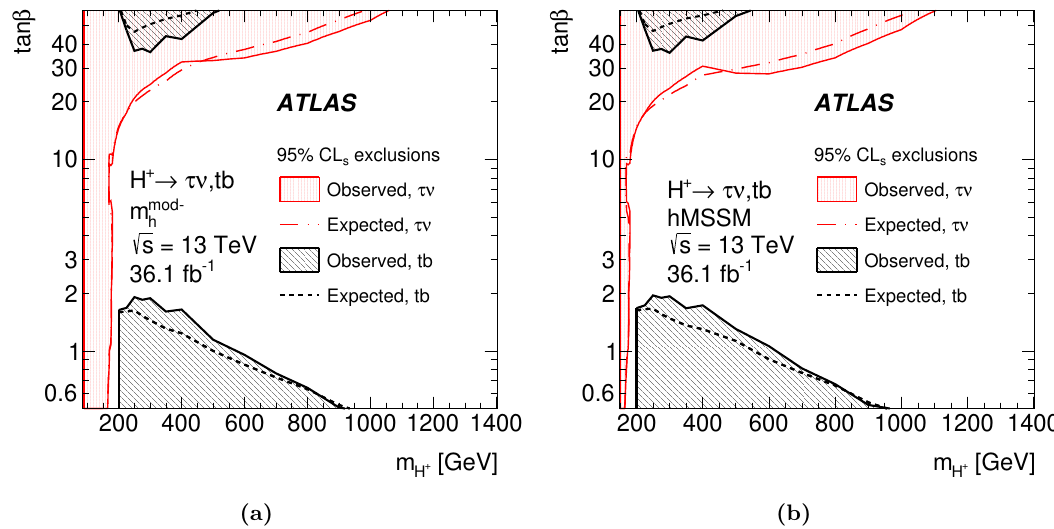
Figure 10. Expected and observed limits on tan (cid:12) as a function of m and the hMSSM [29] (right) scenarios of the MSSM. Limits are shown for tan (cid:12) values in the range of 0.5{60, where predictions are available from both scenarios. The limits are a superposition of the results obtained in the analysis presented here, and the ATLAS limits derived from the H + ! (cid:28)(cid:23) decay [30]. The expected limits from the (cid:28)(cid:23) (cid:12)nal state are shown as the horizontally hatched area, with the observed limit as a dash-dotted curve. The expected limits from the tb (cid:12)nal state are shown as diagonally hatched areas, with the observed limit as dashed lines. At low tan (cid:12) , the strongest limits are from the tb (cid:12)nal state, whereas the exclusions at high tan (cid:12) and low H + masses are obtained from the (cid:28)(cid:23) (cid:12)nal state. The exclusion limits for the hMSSM scenario are shown only for m > 150 GeV, where the corresponding theoretical predictions are H +